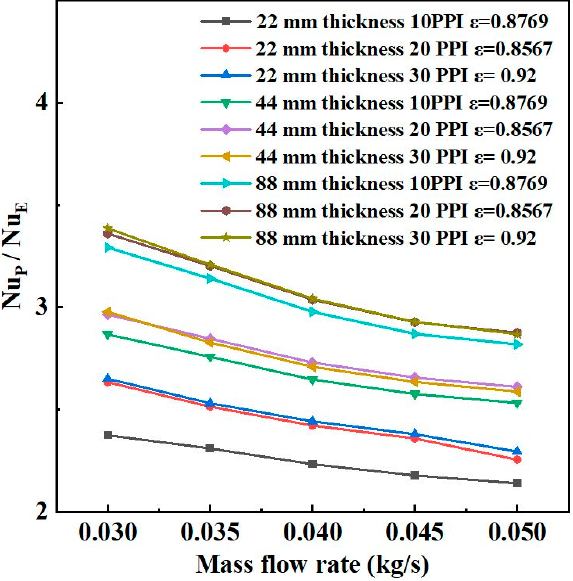
Figure 14. The change in the ratio of Nu P /Nu E for different mass flow rates for different PPI and different thicknesses .